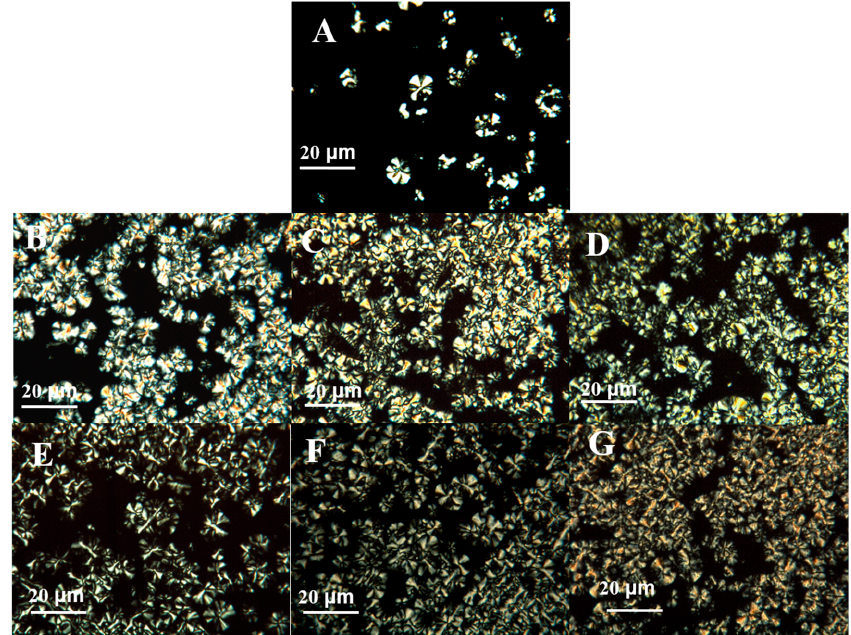
Figure 15. POM images of ( A ) PCL, ( B ) PCL/APIBPOSS ‐ 2, ( C ) PCL/APIBPOSS ‐ 5, ( D ) PCL/APIBPOSS ‐ 10, ( E ) PCL/APIOPOSS ‐ 2, ( F ) PCL/APIOPOSS ‐ 5, and ( G ) PCL/APIOPOSS ‐ 10 nanocomposites, at 38 °C during non ‐ isothermal crystallization from their melts at a cooling rate of 2 °C min − 1 .